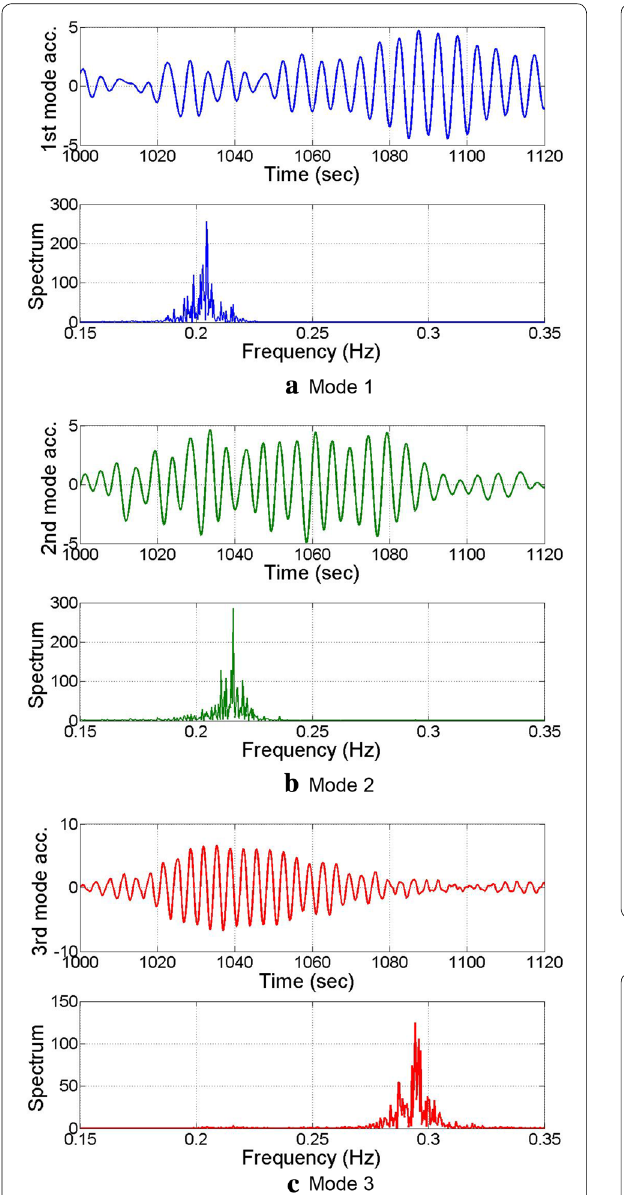
Fig. 15 Decomposed modes and spectra.